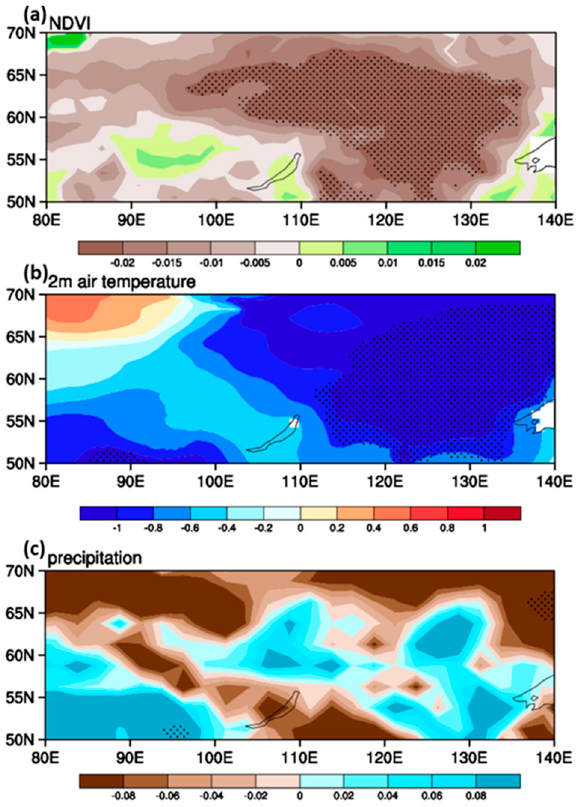
Figure 7. Composite anomalies of ( a ) NDVIsn; ( b ) SAT (unit: °C) and ( c ) precipitation (unit: mm/day) during spring in the EP El Niño years over East Russia. Dotting areas have the anomalies being statistically significant at the 0.1 level (i.e., p < 0.1) estimated by a local Student’s t -test. Next, we focus on how the EP El Niño events influence the spring temperature over East Russia.